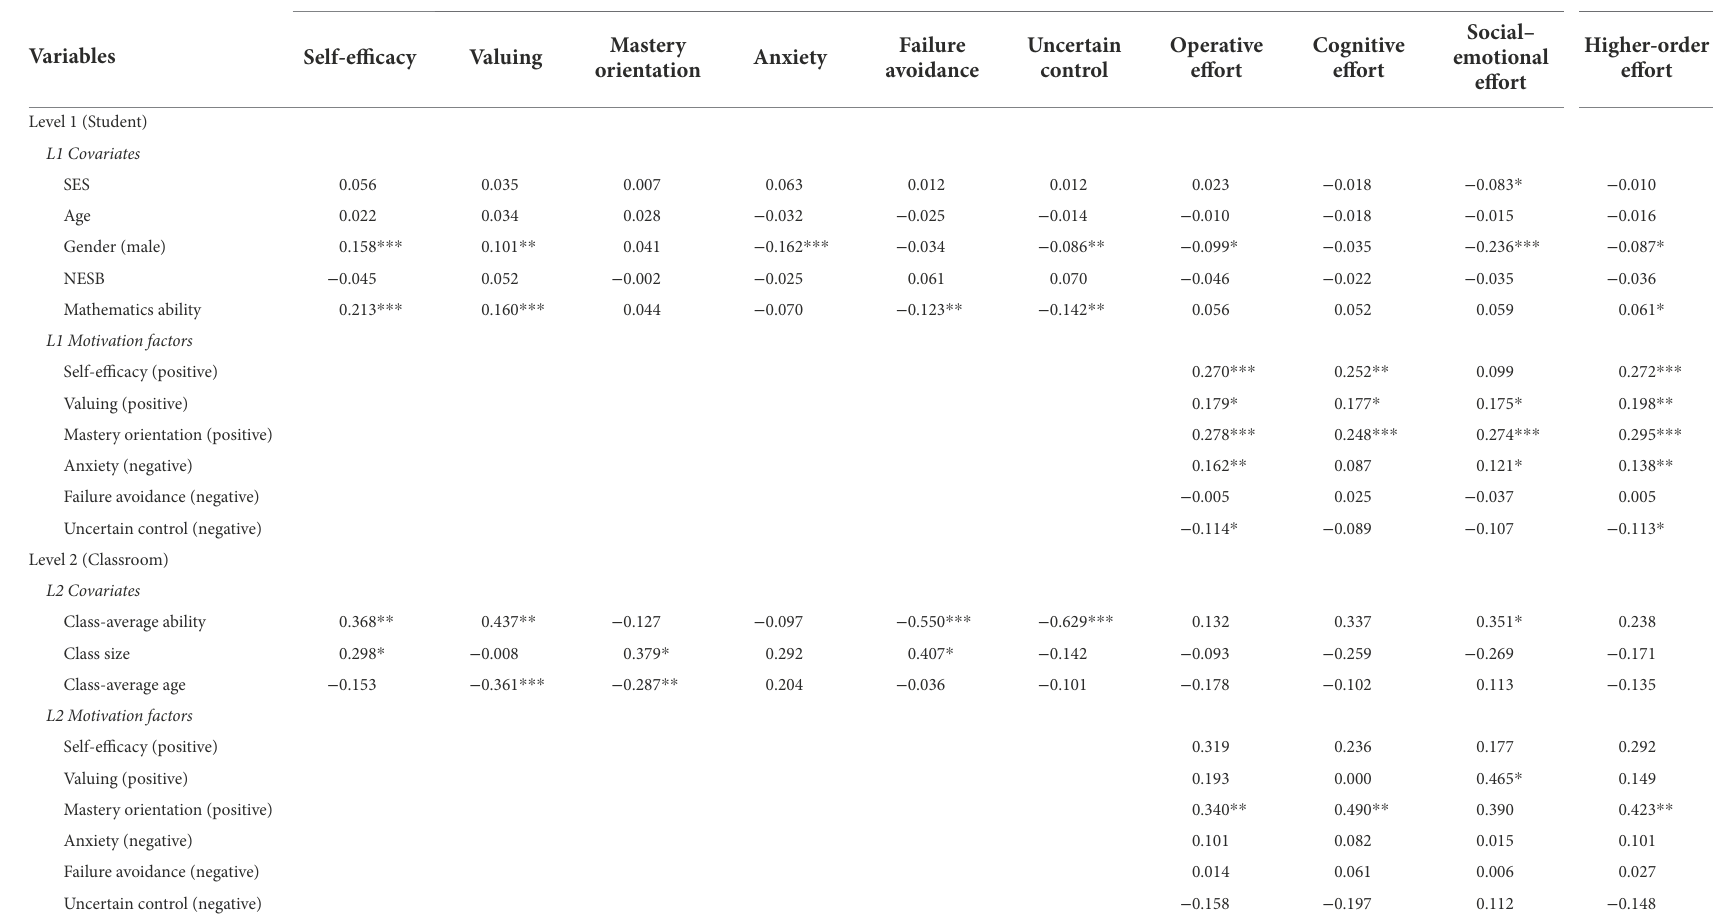
TABLE 3 Multilevel structural equation process model: Standardized beta